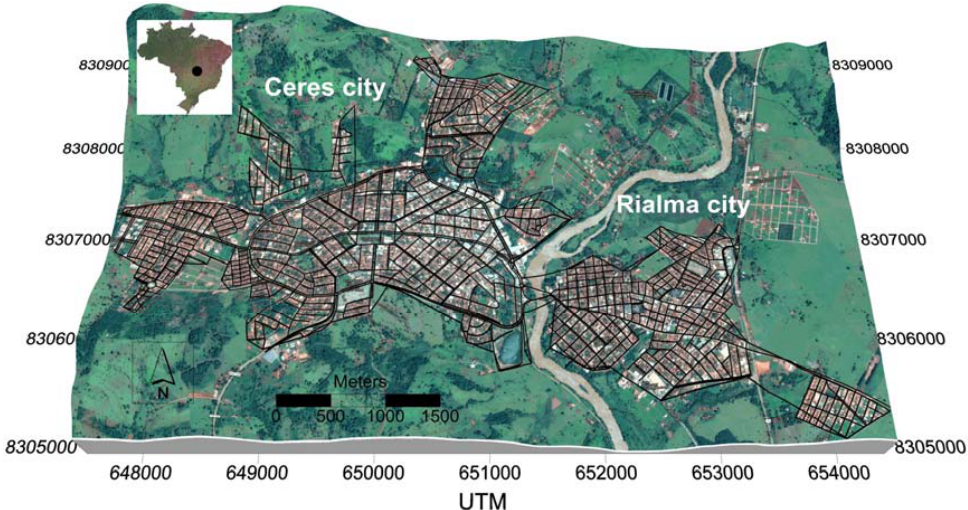
Figure 1. Location of the cities of Ceres and Rialma.